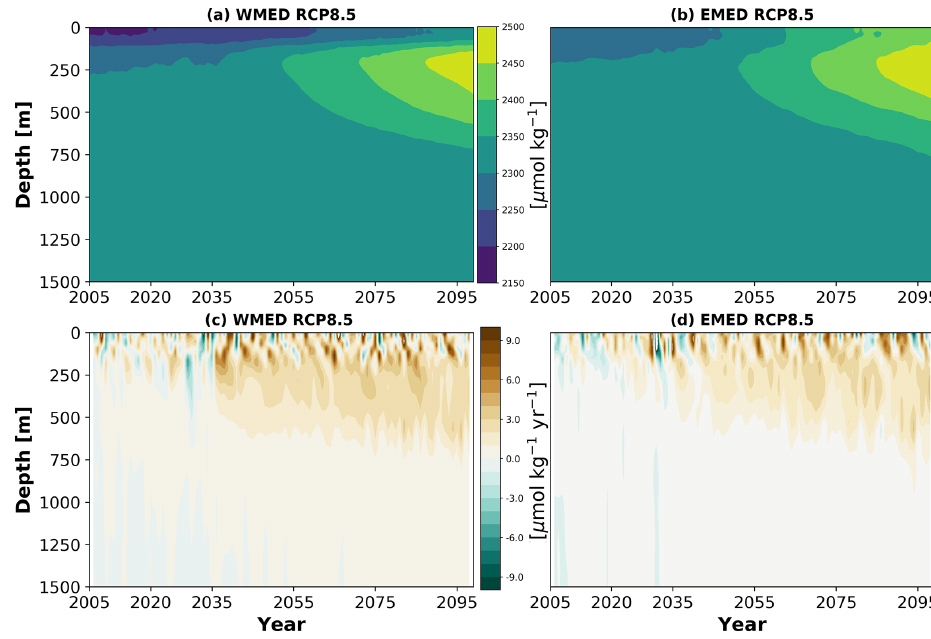
Figure 17. Hovmoeller diagrams of DIC (µmolkg − 1 , a , b ) and annual rates of change of DIC (µmolkg − 1 yr − 1 , c , d ) in the Western (a, c) and Eastern (b, d) Mediterranean Sea in the RCP8.5